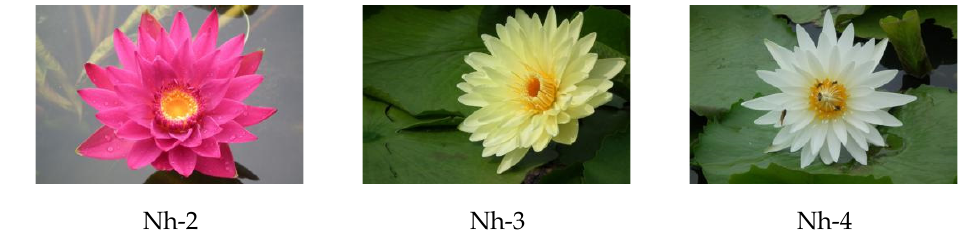
Figure 8. Experimental materials used in this study. Nh ‐ 1, Nh ‐ 2, Nh ‐ 3, and Nh ‐ 4 represent the blue ‐ purple, pink, yellow, and white types of N.